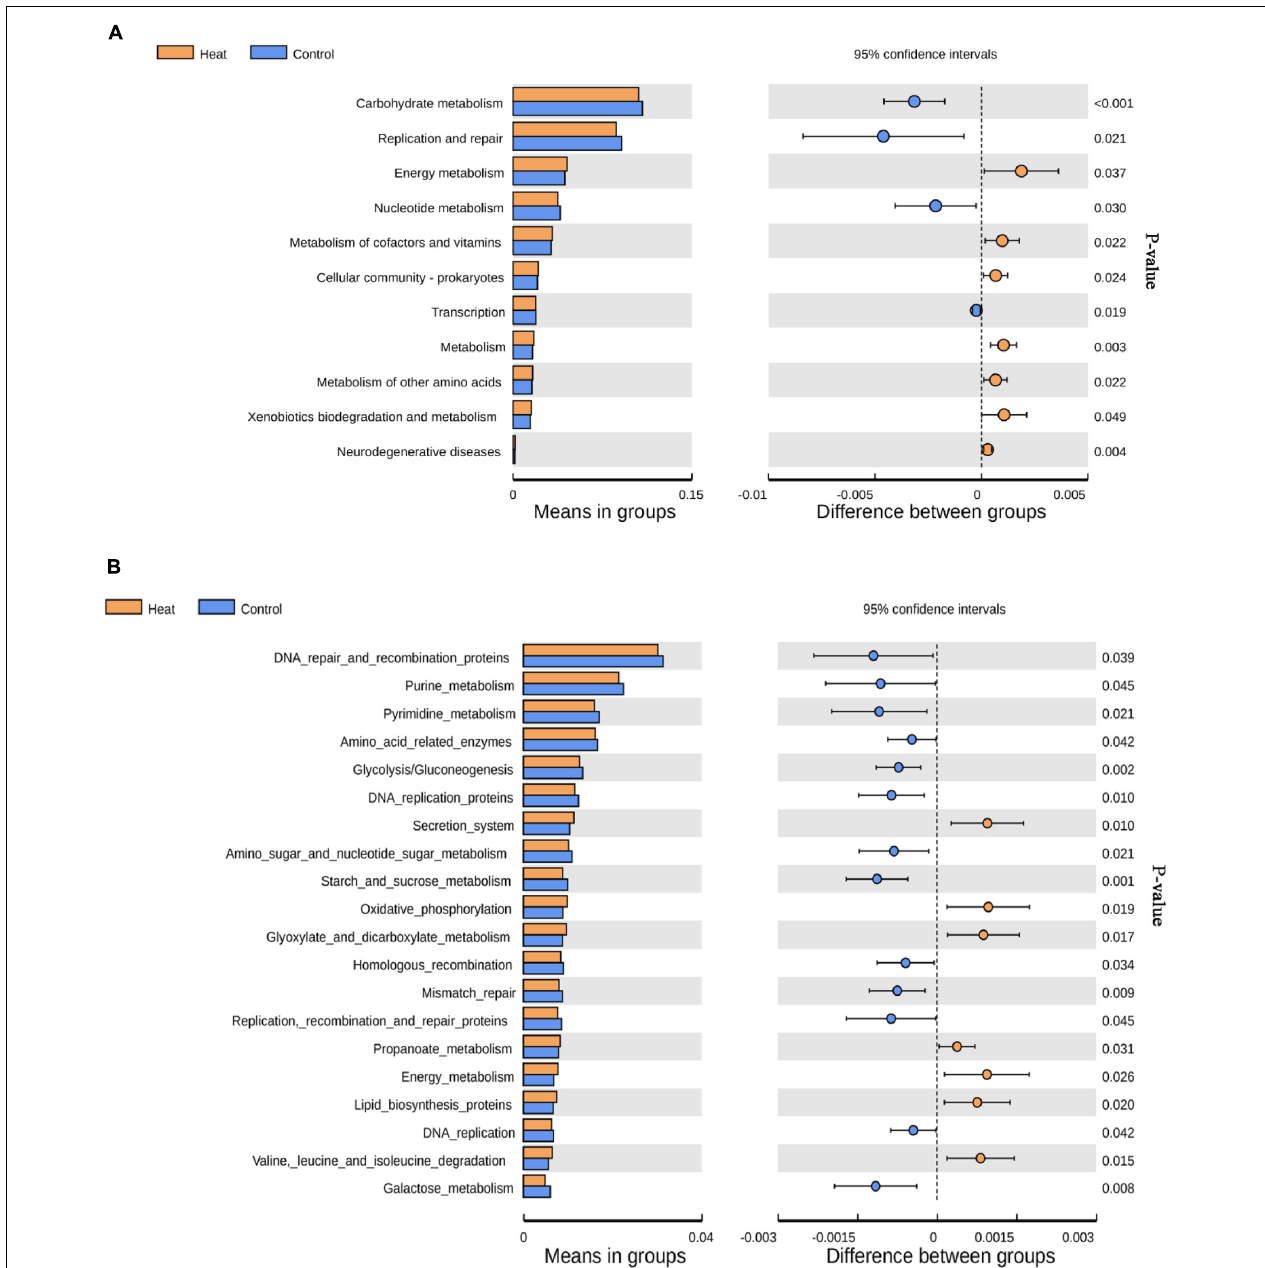
FIGURE 4 | KEGG pathways affected by heat stress. (A) The level 2 KEGG pathways with statistically significant difference. (B) The top 20 level 3 KEGG pathways with the most significant difference between the Heat and Control groups. P < 0.05 indicates that the pathway is differentially enriched by the Heat and Control